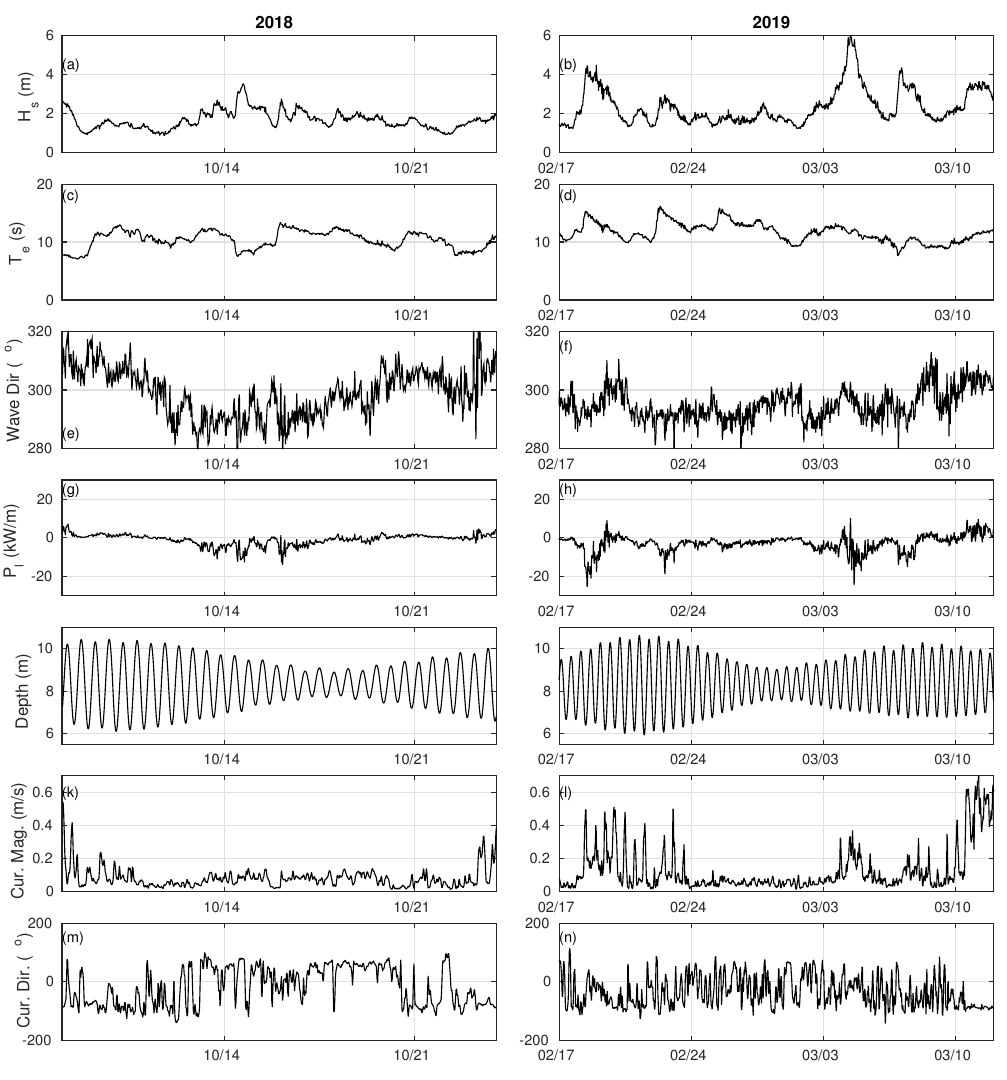
Figure 3. Field conditions during the 2018 (left-hand panels) and 2019 (right-hand panels) deployments. ( a , b ) Significant wave height; ( c , d ) energetic wave period; ( e , f ) mean wave direction (>300 ◦ Northward, <300 ◦ Southward); ( g , h ) longshore wave power; ( i , j ) measurement depth; ( k , l ) 2-h-averaged current magnitude and ( m , n ) direction against the headland projected into a cross-shore/alongshore local reference frame ( > 0 Northward, < 0